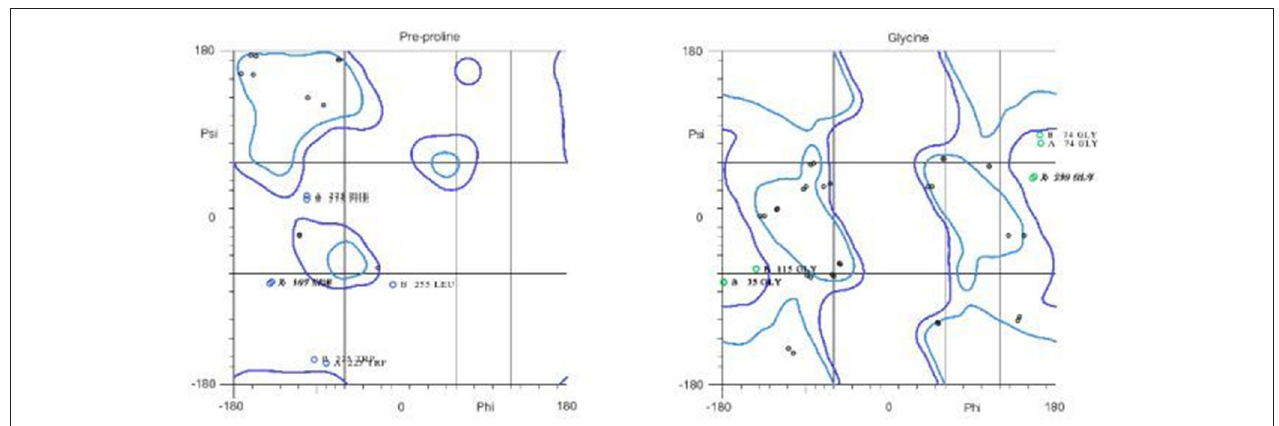
FIGURE 9 | Residues in favored and allowed regions in the Ramachandran plot of Fief obtained from http://www.ebi.ac.uk/.